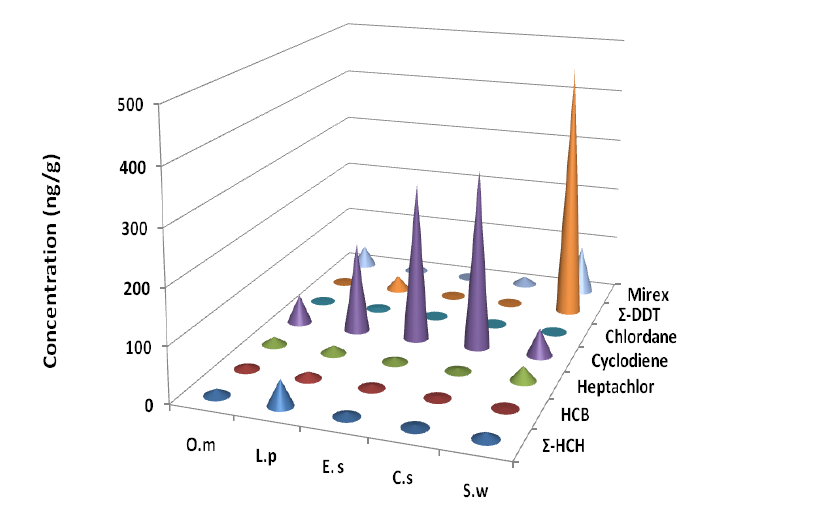
Figure 3. Mean concentration of OCPs in fish species from River